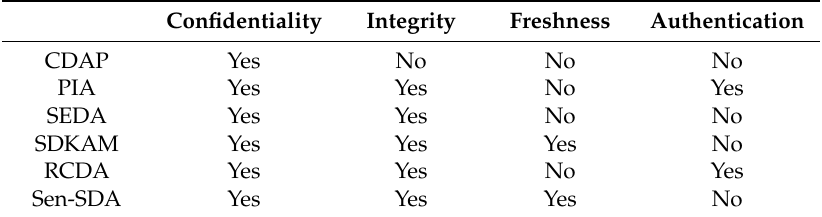
Table 3. Ensured security issues of end to end data aggregation security